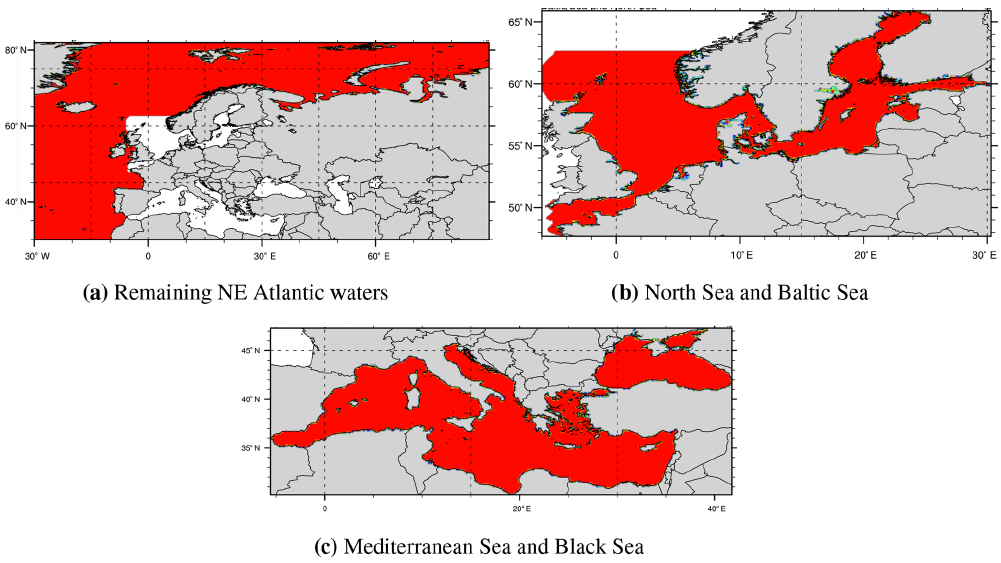
Figure 1. The individual sea areas are marked in red. Shipping emissions in all other sea areas are classified as ROW (rest of world) shipping.